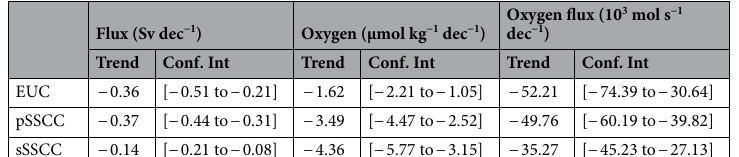
Table 2. EUC and SSCC mass and oxygen flux trends over 1970–2008. Linear trend of the eastward mass flux (in Sv dec −1 ), oxygen concentration (in μmol kg −1 dec −1 ), and eastward oxygen flux (in 10 3 mol s −1 dec −1 ) associated with the near-equatorial eastward jets (EUC, pSSCC, sSSCC), computed at 88° W over 1970–2008 from the control simulation (Si-Control). Eastward velocities greater than 0.2 cm s −1 are considered in the